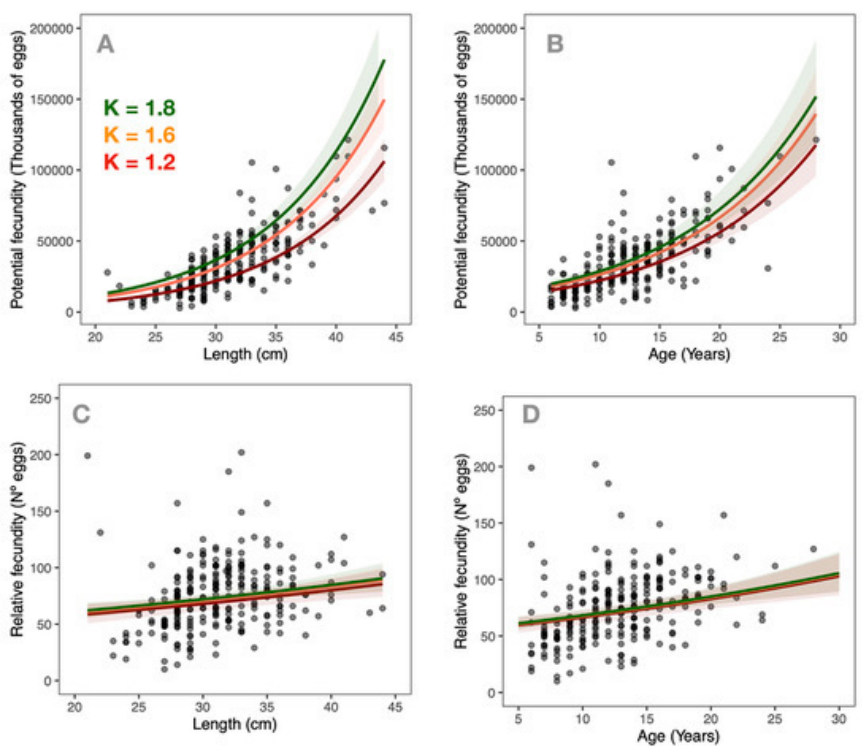
Fig. 3. – Relationship and fitted curves between potential fecundity by length (A) and age (B), and between relative fecundity by length (C) and age (D) of S. fasciatus on the Flemish Cap between 1996 and 2020. Data were fitted for three different values of condition factor (K=1.2, K=1.6 and K=1.8)